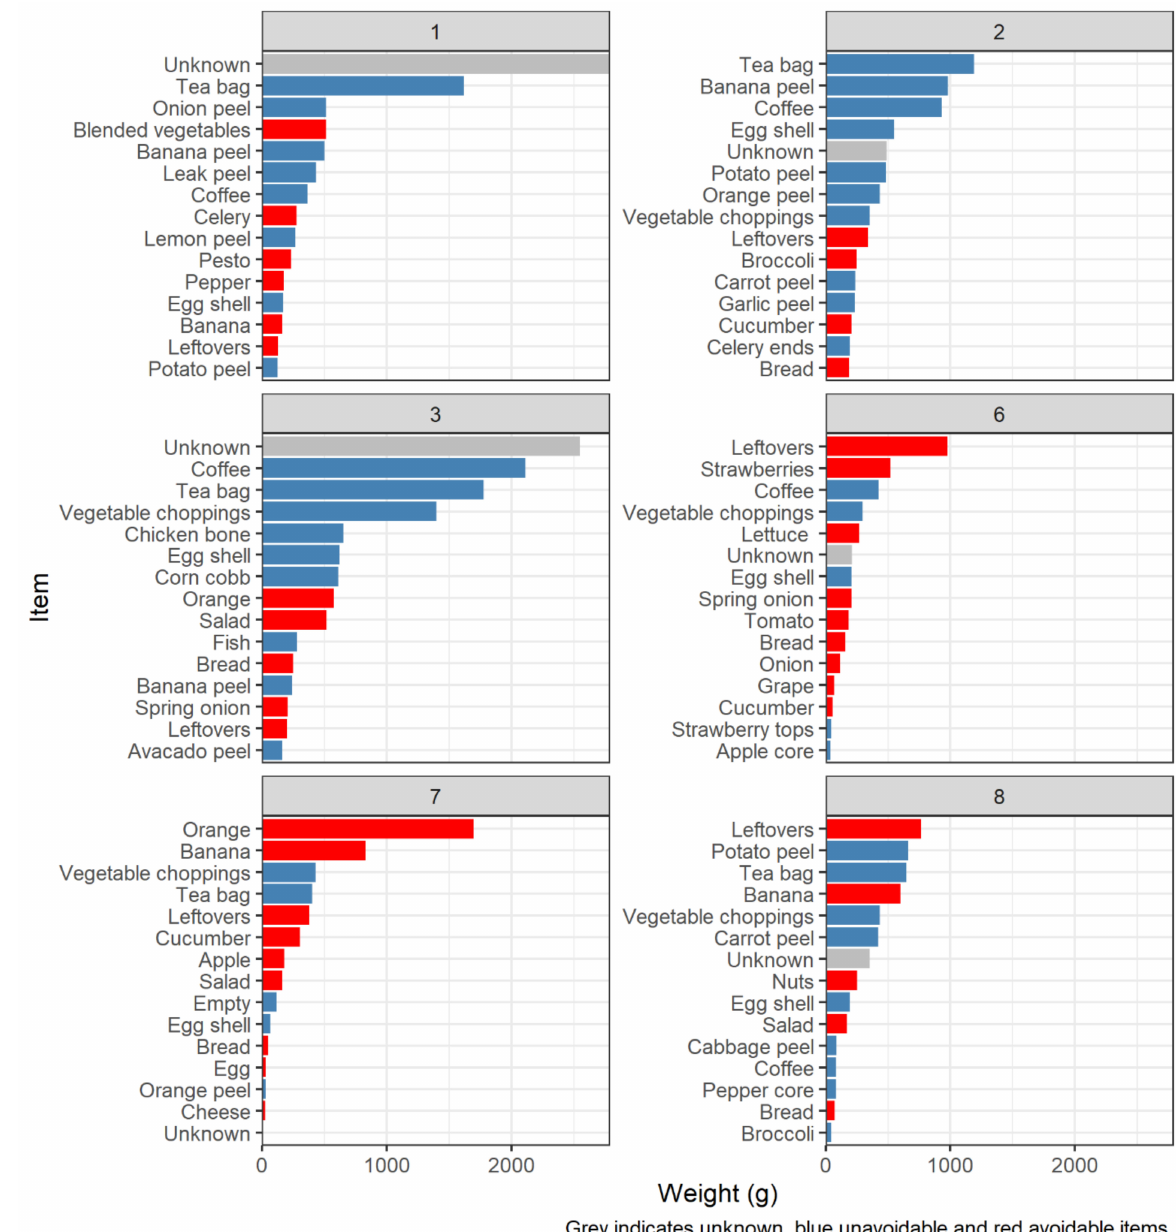
Figure 6. Top 10 items by